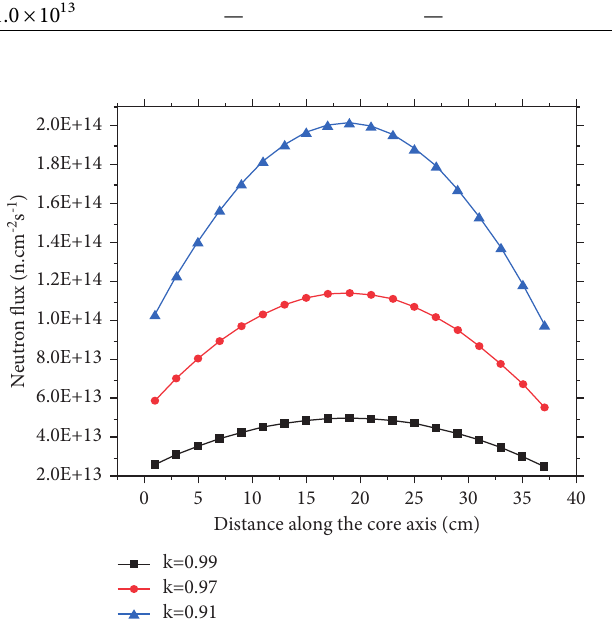
Figure 5: The axial distributions of neutron flux with ThUO fuel placed in molten lead. Table 5: Neutron flux of ThUO and UZrH fuel in molten lead.